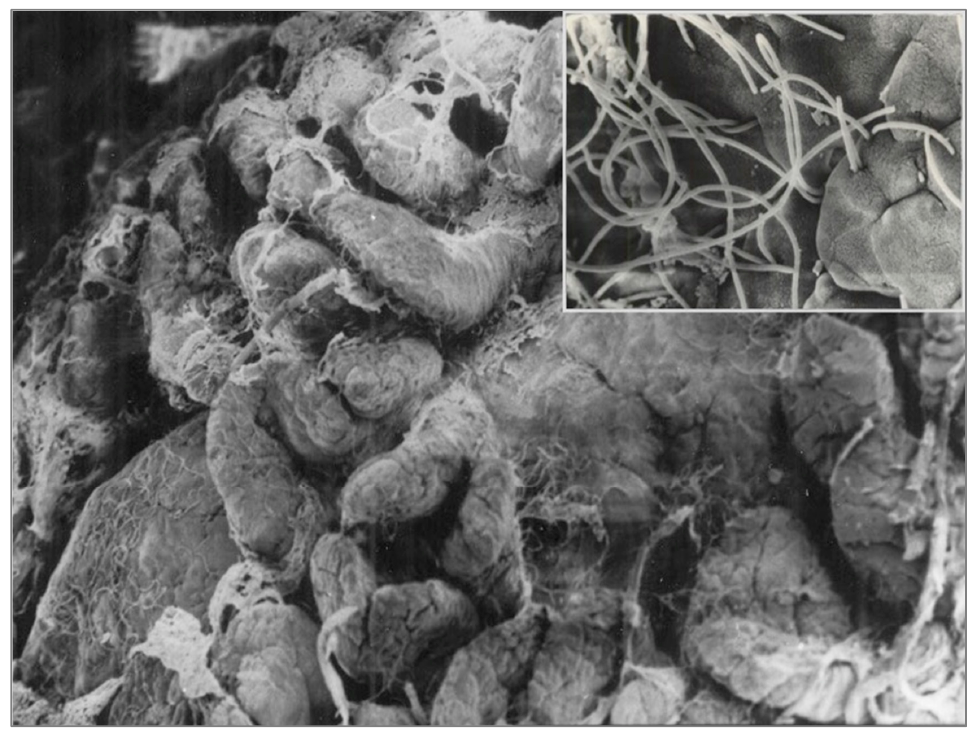
Figure 3. Scanning electron microscopy images, showing SFB (segmented filamentous bacteria) inside and outside the Peyer’s patches.